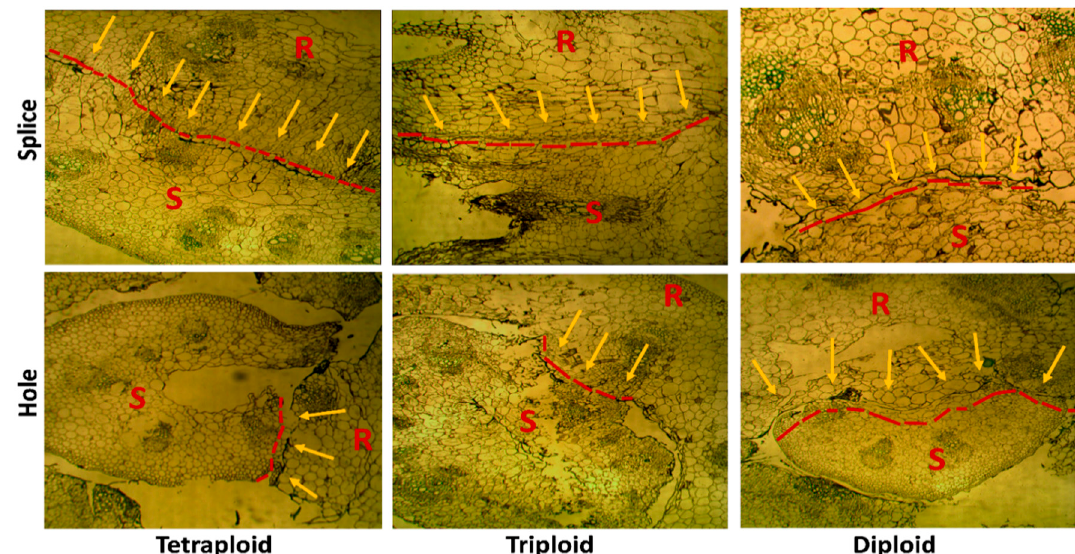
Figure 9. Anatomical observation of Di, Tri, and Tetra watermelon grafted on squash rootstock using splice and hole grafting methods at 15 Days after grafting (zoom 40 × ), arrows indicate connection region between scions and rootstock. R: rootstock, S: Scion.